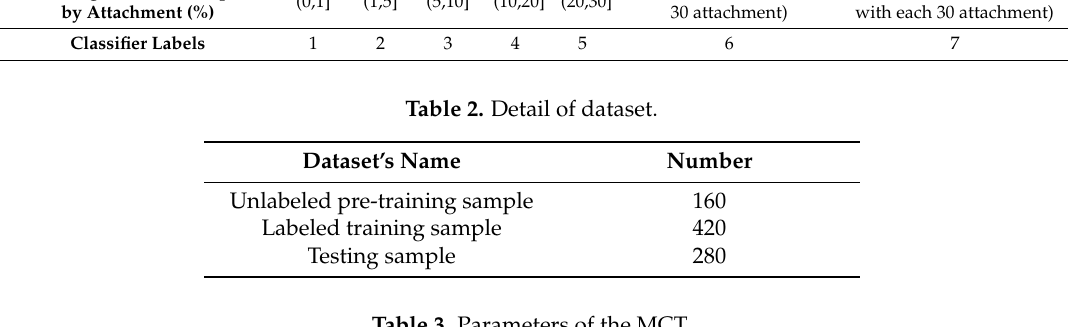
Table 3. Parameters of the MCT.